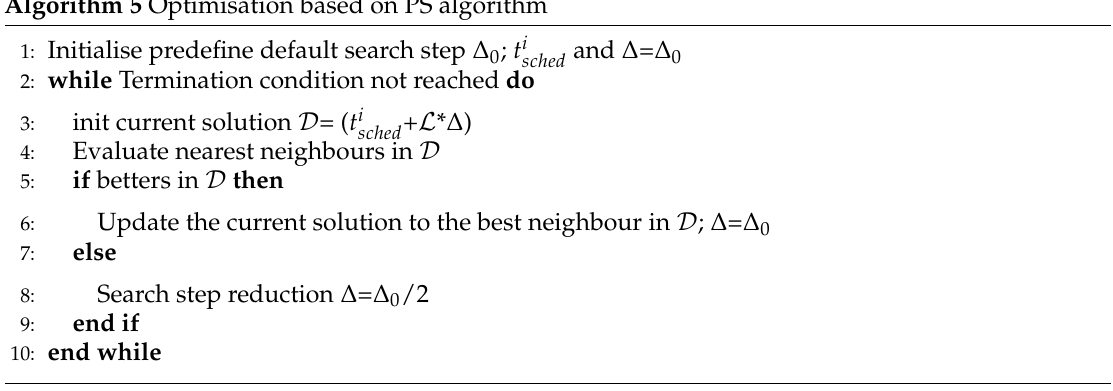
Algorithm 5 Optimisation based on PS